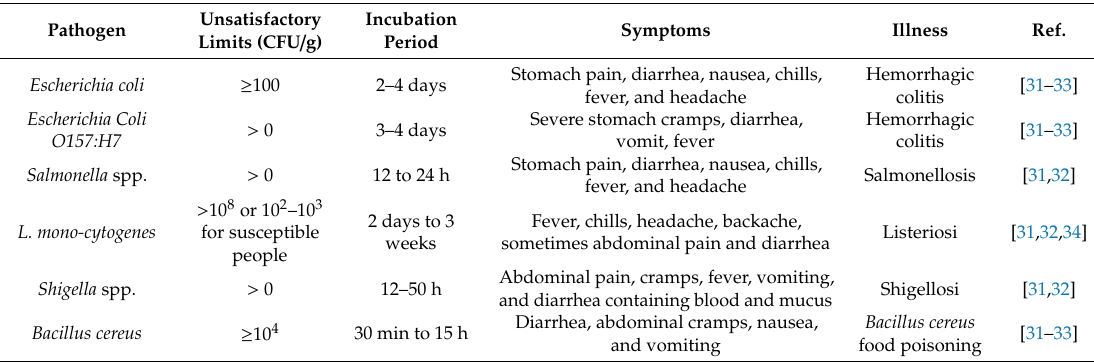
Table 1. Pathogens in vegetables responsible for foodborne